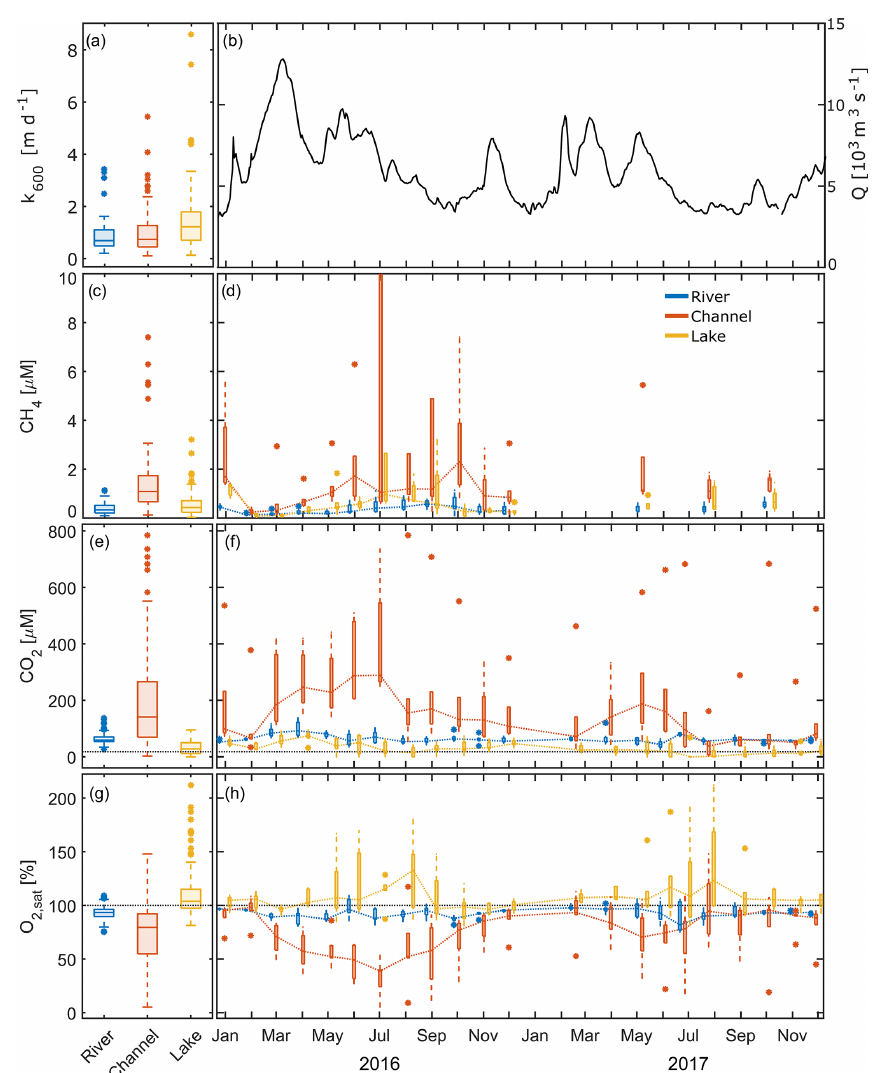
Figure 4. Here, k 600 (a) , daily average discharge close to the apex (b) and measured concentrations of dissolved gases in the different waterscapes, i.e. river, channel and lake (c–h) , are shown. (a, c, e, g) Pooled data from 2 years. (d, f, h) Seasonal dynamics, with dotted lines connecting median values. The x axis ticks indicate the 15th day of the respective month. (c, d) CH 4 in 2016, with four channel values (ranging from 22.2 to 58.0µM) and one lake station (12.5µM) exceeding 10µM cut off. (e, f) Dotted black line represents the equilibrium concentration of CO 2 at 15 ◦ C (18.2µM). Box plots indicate the 25 and 75 percentiles and median; whiskers indicate maximum and minimum, with data > 1.5 × IQR shown as